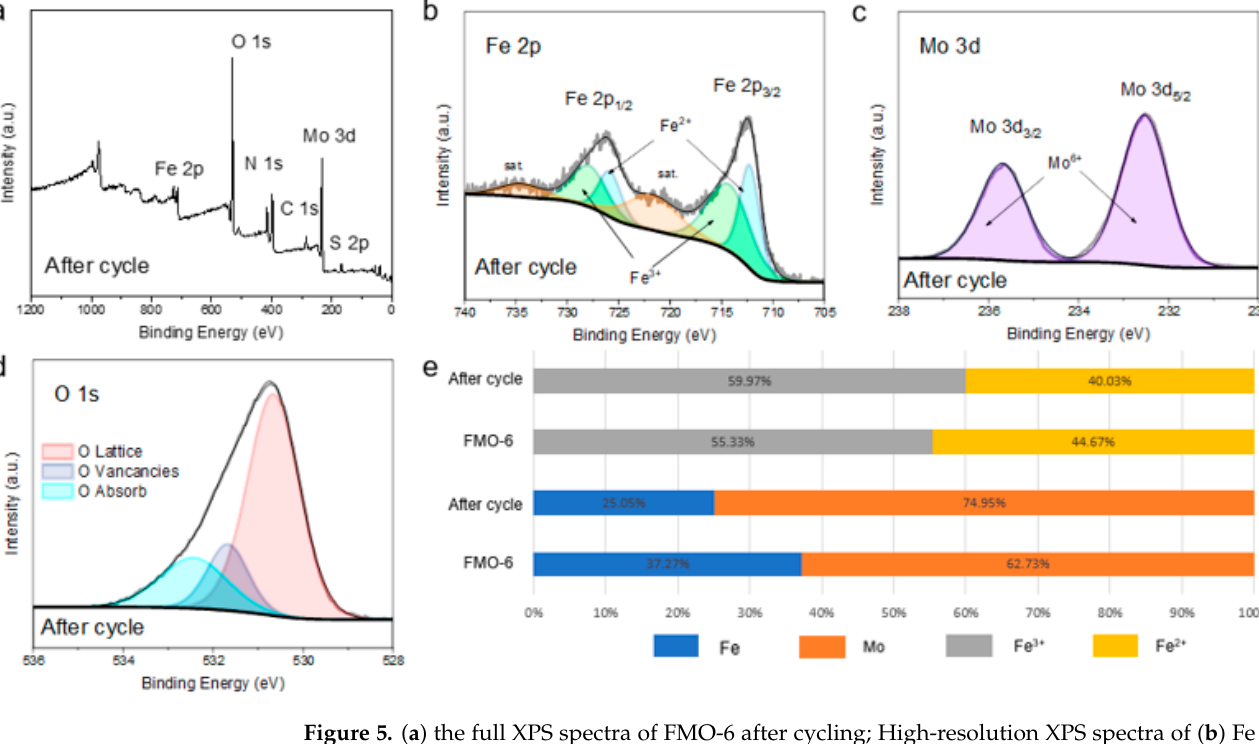
Figure 5. ( a ) the full XPS spectra of FMO-6 after cycling; High-resolution XPS spectra of ( b ) Fe 2p ( c ) Mo 3d and ( d ) O 1 s of FMO-6; ( e ) calculated Fe/Mo ratio and Fe 3+ /Fe 2+ ratio.